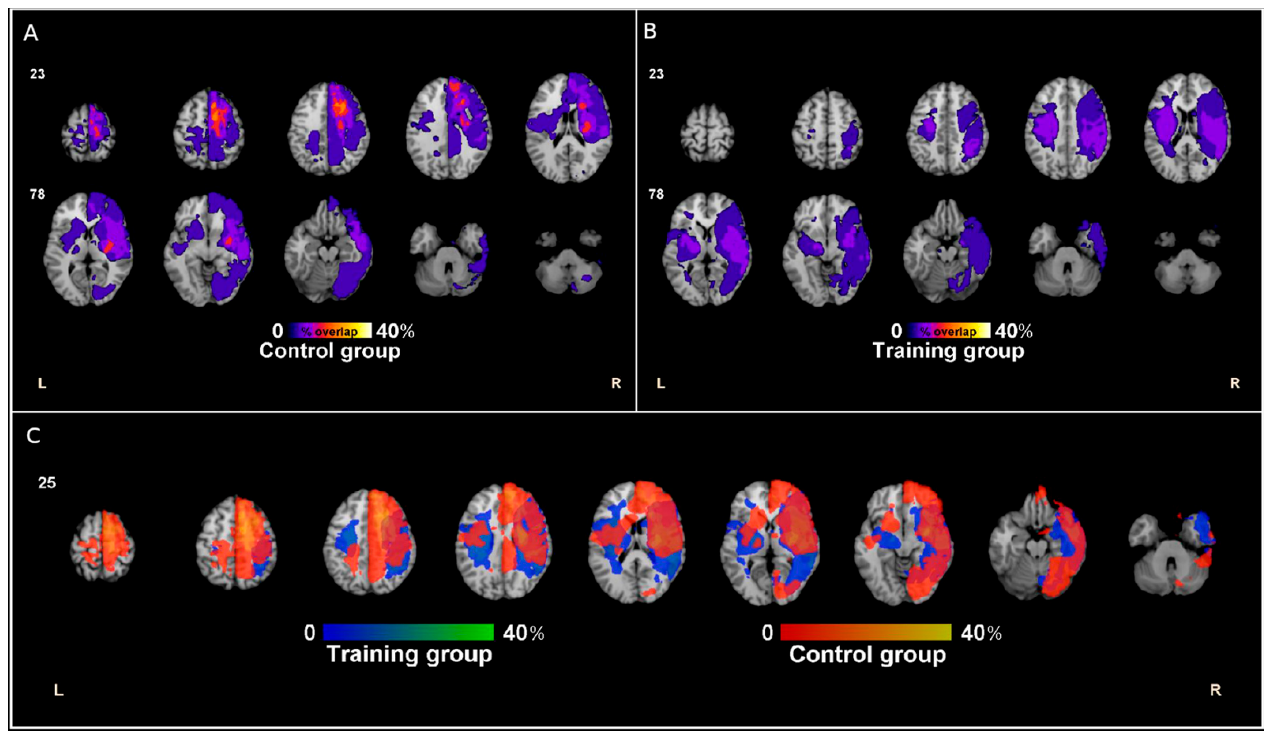
Figure 1. Lesion coverage proportion maps of training and control groups. Lesions were manually segmented and overlaid onto the reference standard brain template by means of the clinical toolbox [27,28]. The percentage values represent the lesion overlap within ( A , B ) and between ( C ) groups.